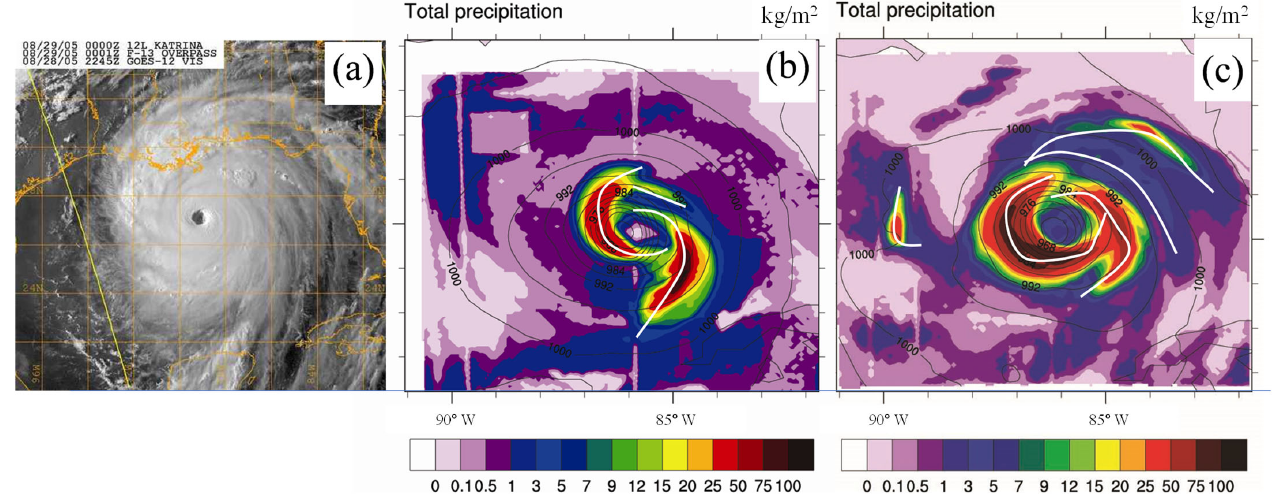
Figure 7. The total precipitation (mm) determined based on ( a ) satellite composite imagery (courtesy